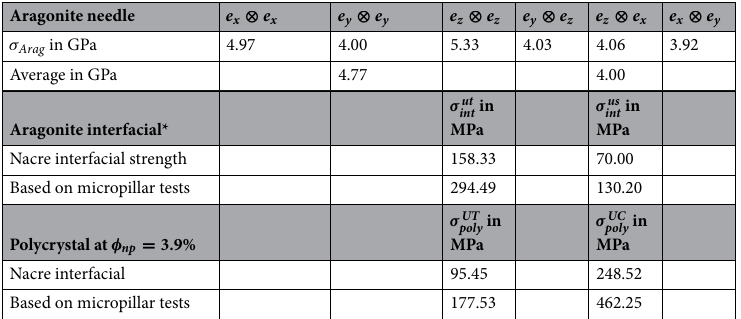
x , y , z denote directions of testing in (cid:31) (cid:30)